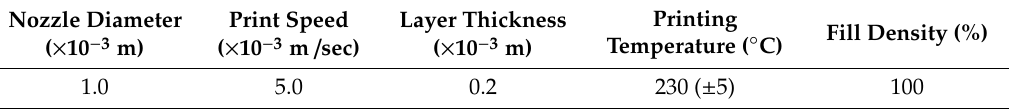
Table 1. 3D printing conditions of dog-bone style for the tensile strength